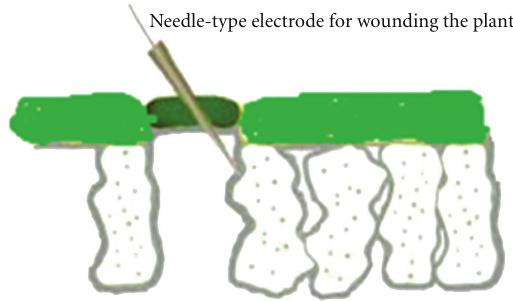
Figure 1: Insertion of electrodes through the stomata (small pores; the leaf is in dark green color) into the inner tissue. Plant electrical signal behavior can be changed by this process.